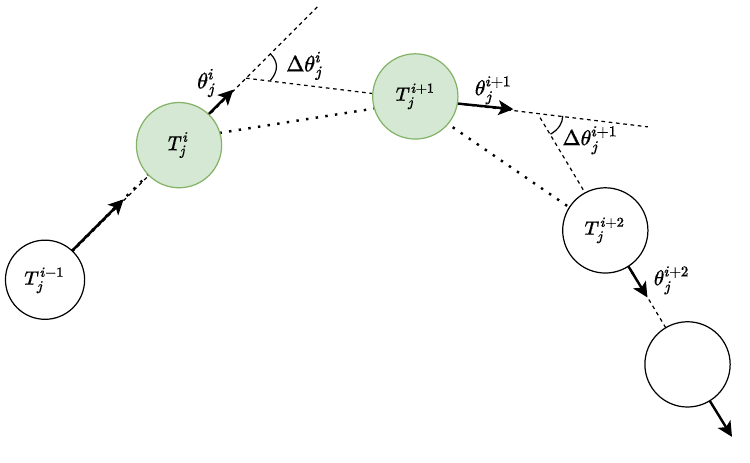
Figure 2. Turning points from course